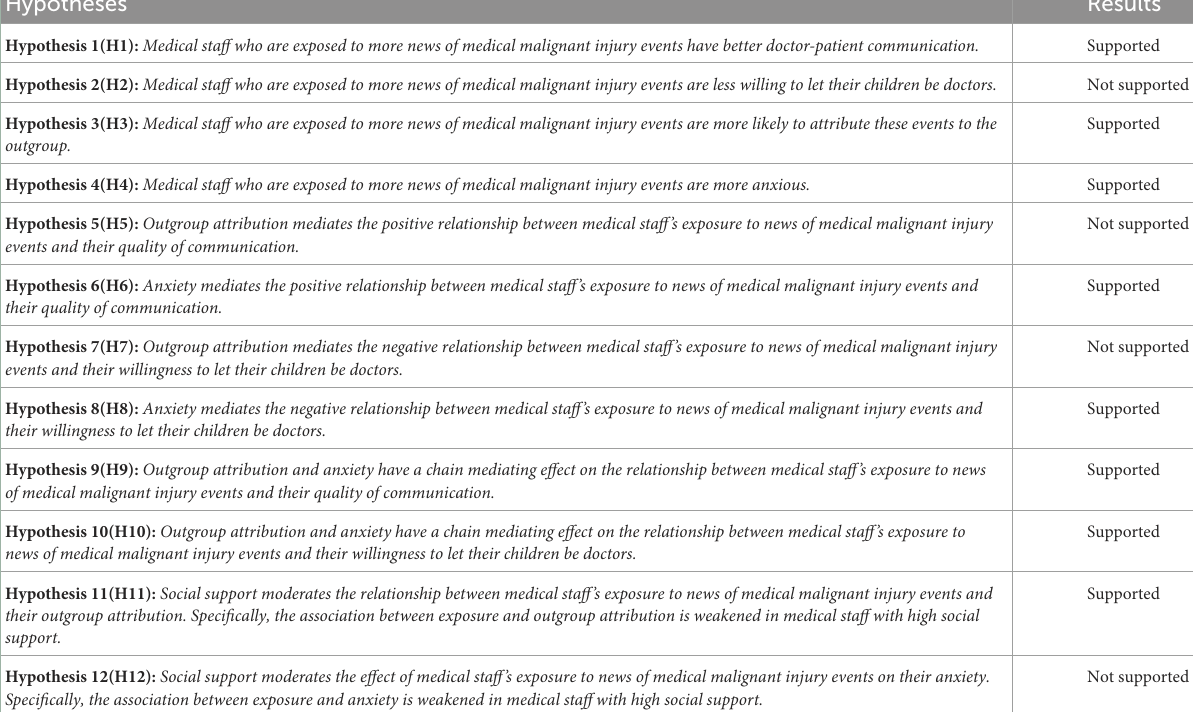
TABLE 4 Results of hypothesis testing.